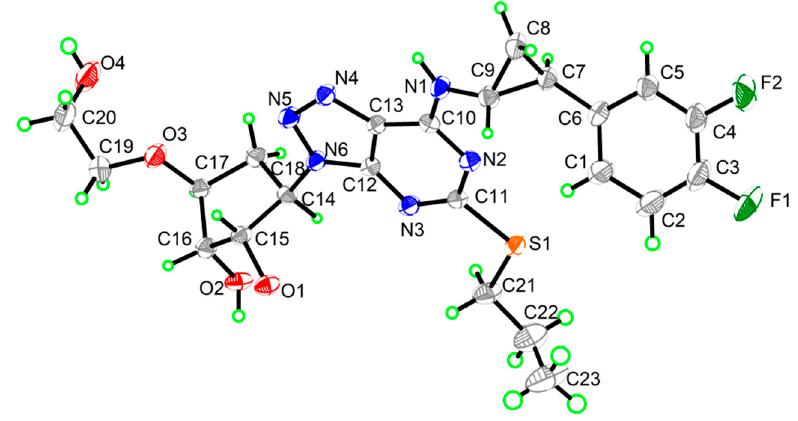
Figure 3. The molecule structure of TICA-II, showing displacement ellipsoids at the 50% probability level.